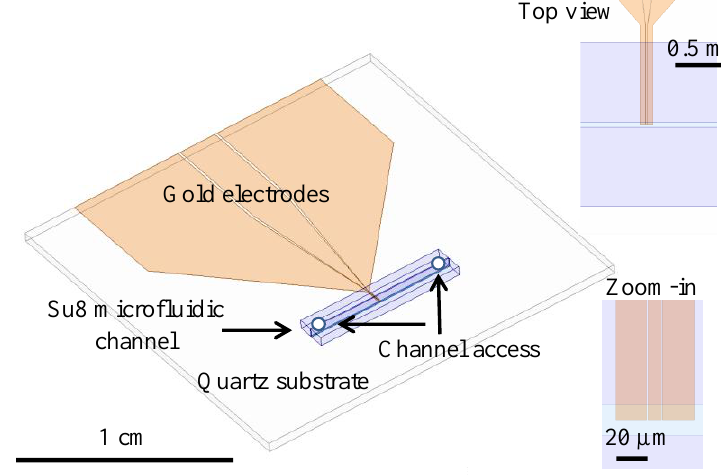
Figure 1. Schematic representation of the microwave/microfluidic sensor (HFSS picture), using gold electrodes in GSG (ground-Signal-Ground) configuration and SU8 microfluidic channel. The inset is a zoom-in.